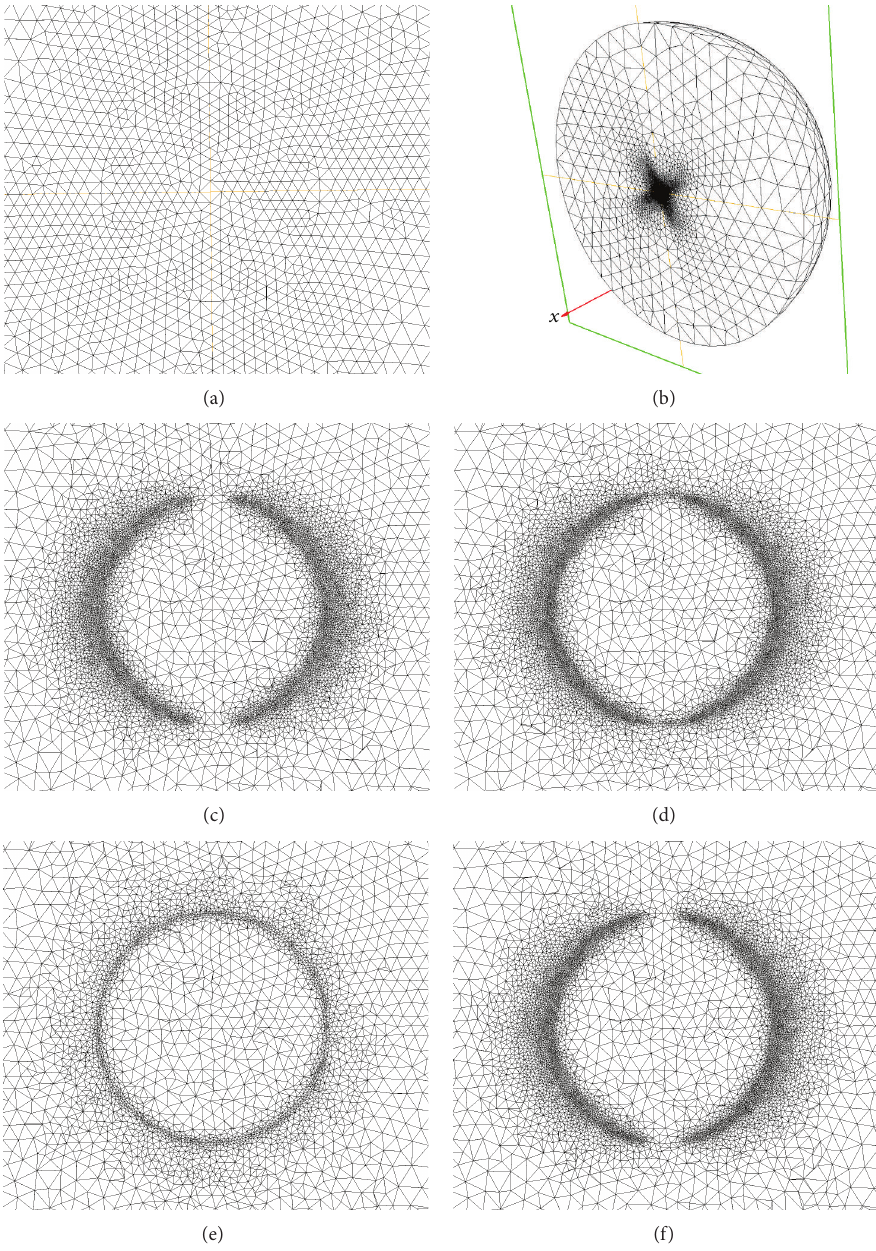
Figure 7: Cut in the median plane 𝑦 = 0: initial mesh (a), 3D view of the mesh (b), and final mesh adapted on ‖ E ‖ 2 with 𝐴 1 (𝑀 𝑖= 8 (Ω)) (c), adapted on 𝑇 with 𝐴 1 (𝑀 𝑖= 8 (Ω)) (d), adapted on 𝑇 with 𝐴 2 (𝑀 𝑖= 6 (Ω)) (e), and adapted on 𝐹 𝑛 with 𝐴 3 (𝑀 𝑖= 5 (Ω))